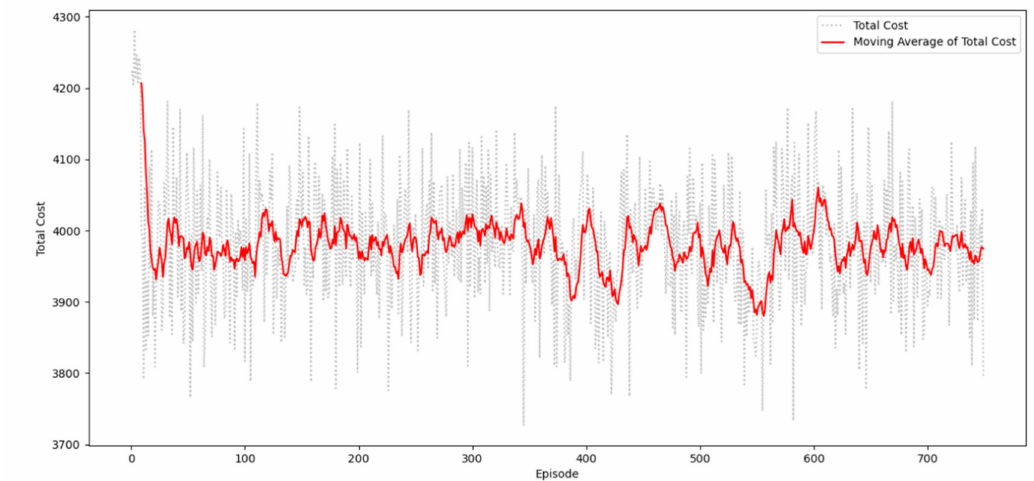
Figure 7. The truck route’s total cost per episode.